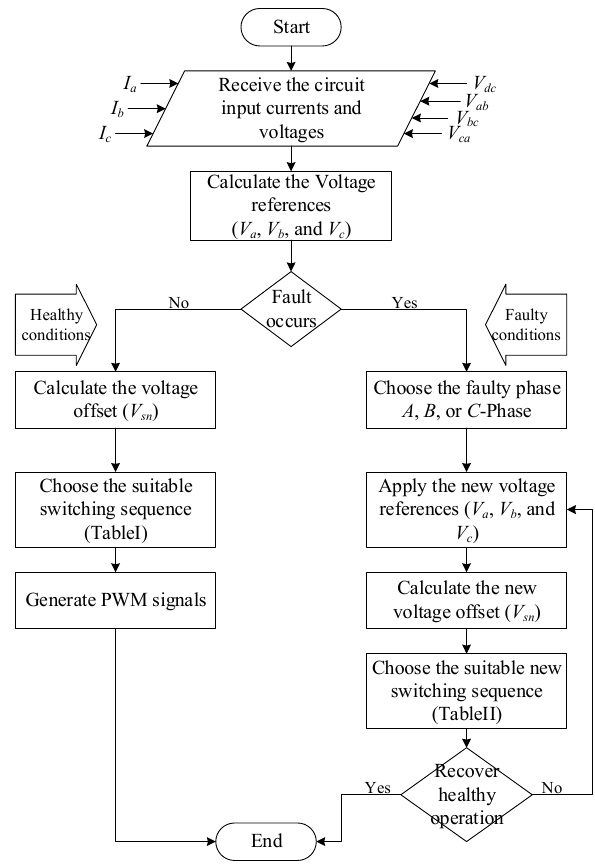
Figure 5. Calculating the new offset flowchart.